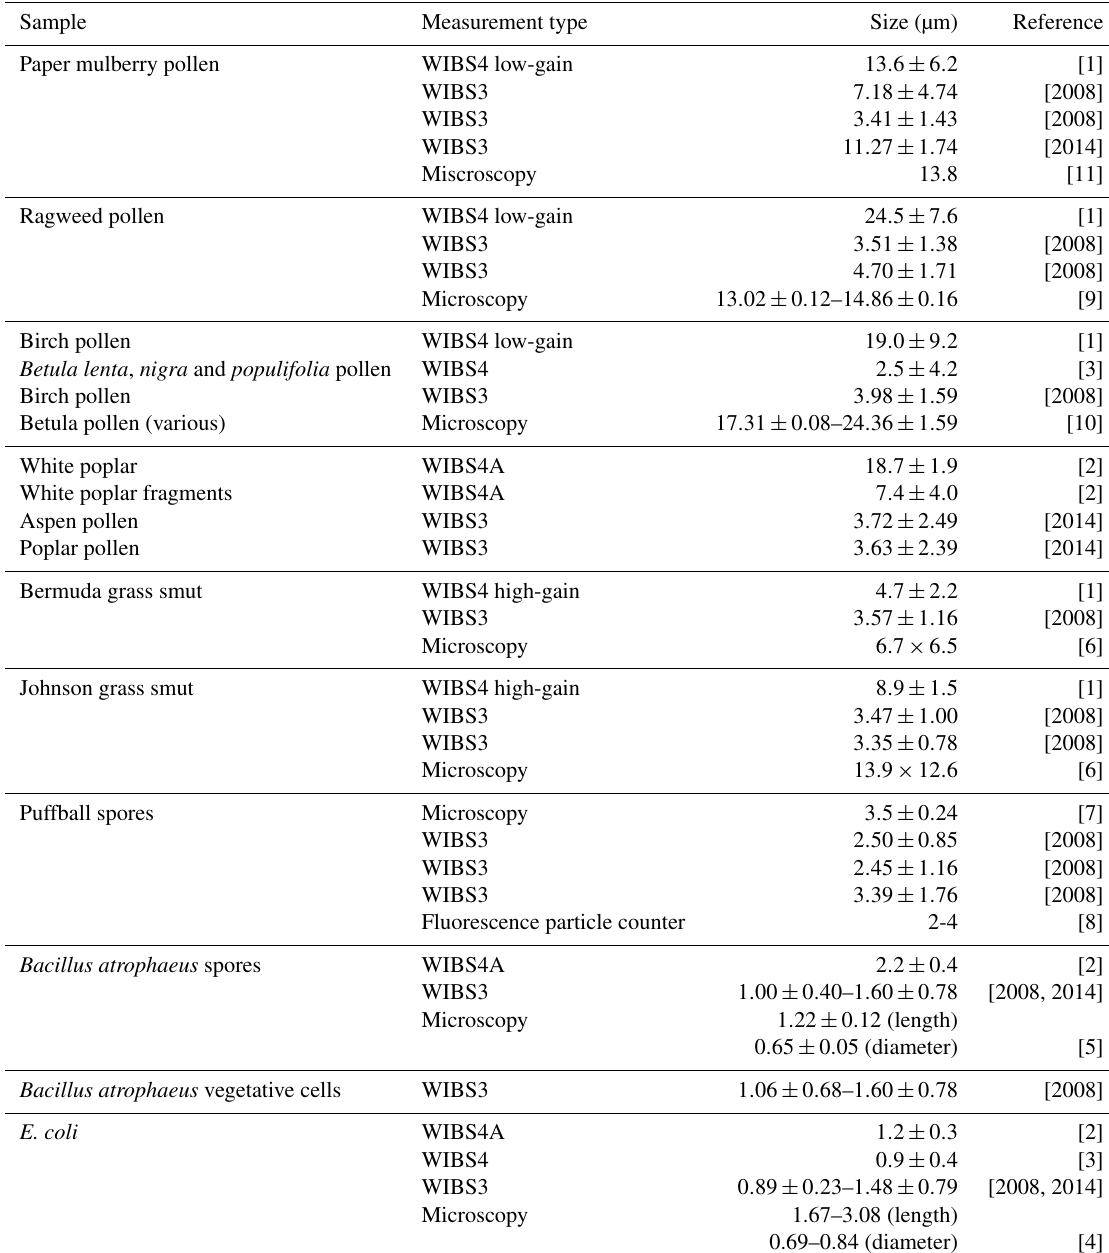
Table A1. Average particle sizes for the current study compared with other studies. The sizes presented here are collated from the following studies [1] Healy et al. (2012a), [2] Savage et al. (2017), [3] Hernandez et al. (2016), [4] Pierucci (1978), [5] Carrera et al. (2007), [6] Crotzer and Levetin (1996), [7] Geiser et al. (2000), [8] Pinnick et al. (1995), [9] Fumanal et al. (2007), [10] Mäkelä (1996), [11] Kang et al. (2007), [2008] and [2014] are taken from the current